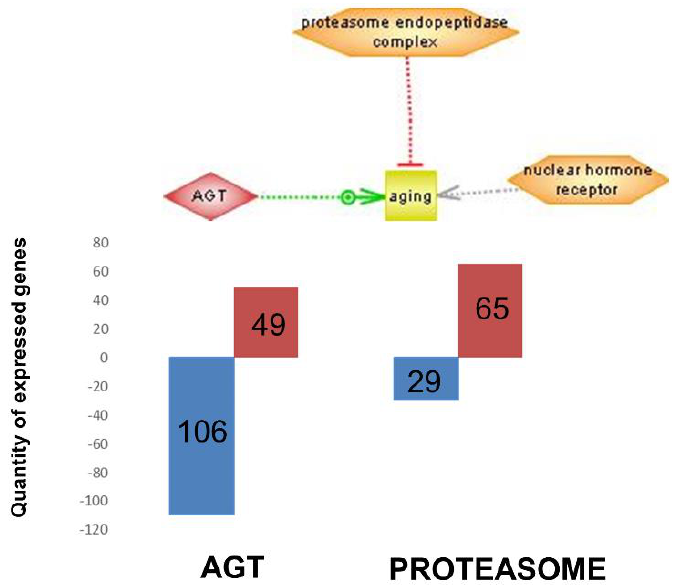
Figure 5. Representation of some of the most important regulators found (see Figure 4) that are related to aging and the total number of genes that are down or overexpressed in this subnetwork. Color of the arrow corresponds to the type of regulation of expression. Green is known positive regulation, red is known negative regulation and grey is a direct regulation, but unknown effect. Bar columns in blue are genes underexpressed and bar columns in red are genes overexpressed for angiotensinogen (AGT) and proteasome subnetworks.